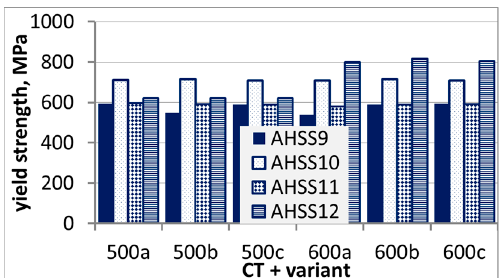
Figure 10. Yield strength of AHSS samples for various coiling temperatures and variants a, b, and c in Figure 2d.